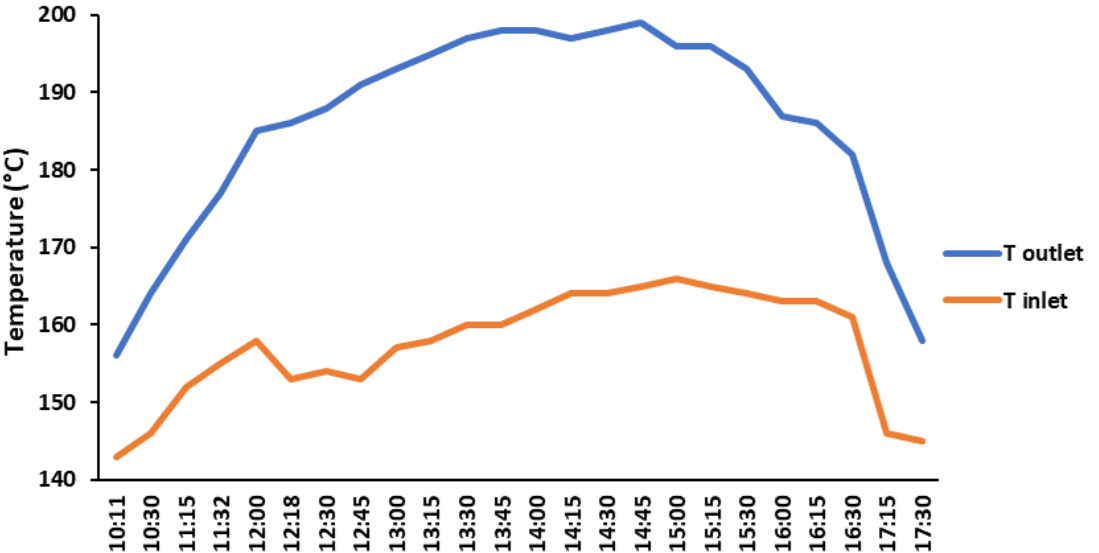
Figure 11. Evolution of temperature upstream and downstream of the PTC solar field for one day.